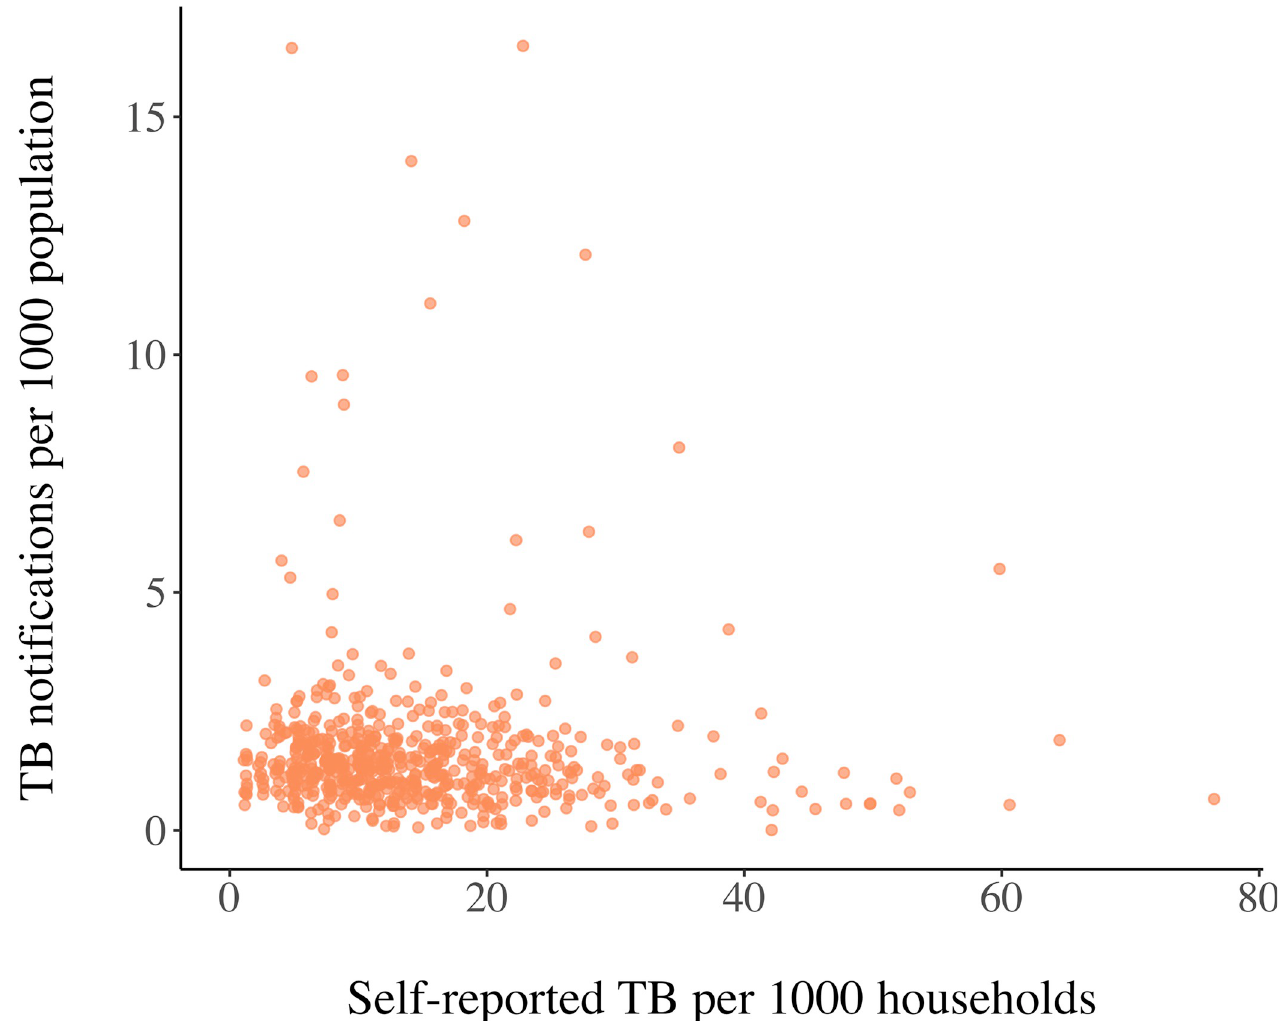
Fig 2. Visualisation of officially reported tuberculosis cases in individuals and households with self-reported tuberculosis at district level in India.